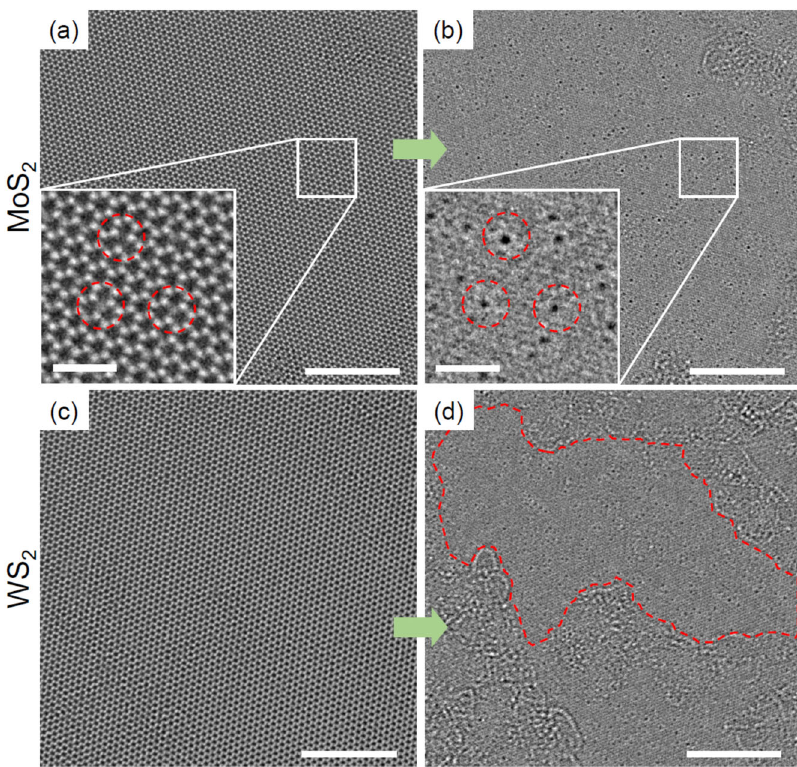
Fig. 4 Measurement of the defect density in TMDs using HRTEM. 60 kV chromatic (Cc) and spherical (Cs) aberration-corrected HRTEM images of CVD grown ML-MoS 2 ( a , b ) and ML-WS 2 ( c , d ). a shows the raw image of the ML-MoS 2 . The area within the white square is magni fi ed in the lower left. A few red circles mark vacancies, which are dif fi cult to see even in the magni fi ed image. Thus, Fourier- fi ltering was applied to remove the frequencies of the MoS 2 lattice, which is shown in ( b ). In b , the same area as in ( a ) is magni fi ed. Due to the Fourier- fi ltering, the vacancies are better visible (black dots, surrounded by red circles). The same procedure was also applied for WS 2 ( c ) raw image and ( d ) Fourier- fi ltered image). Due to the fi ltering, contaminations become also more visible outside the framed area, thus only clean areas were evaluated with certainty for the defect concentration. The scale bars in ( a – d ) is 5 nm. The scale bars in the inset of ( a ) and ( b ) is 1